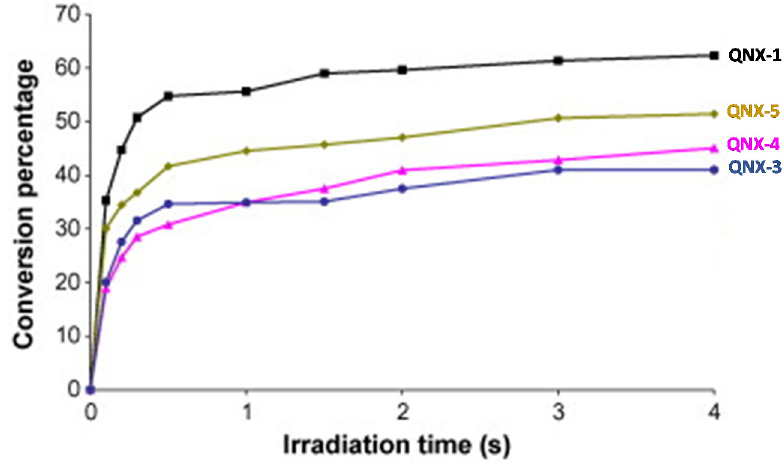
Figure 13. Polymerization profiles obtained during the FRP of TMPTA under air and using the two-component dyes/MDEA (1%/10% w / w ), Reprinted from Ref. [224] Copyright 2007, Elsevier.